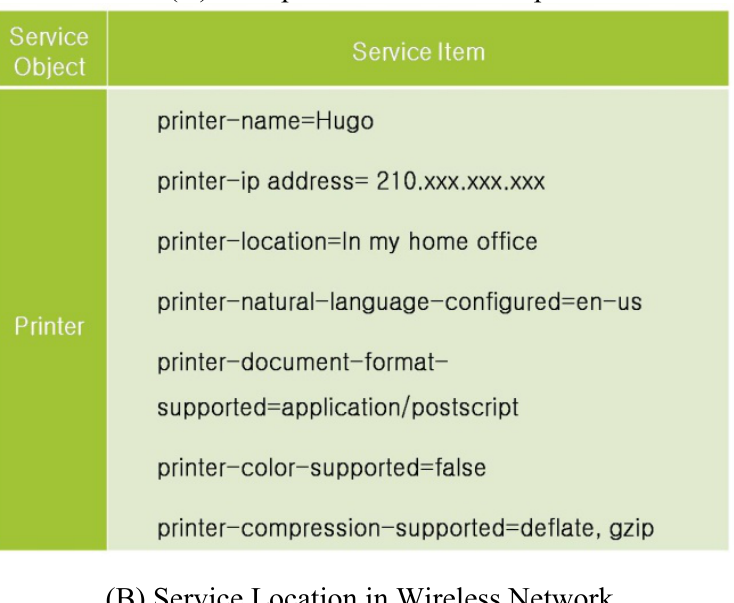
Figure 2. Example of service description and service location in a wireless